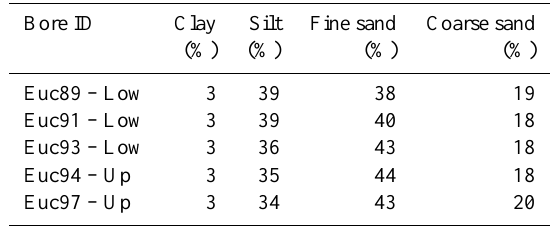
Table 2. Median grain size compositions for sampled profiles used to estimate a range of values for S y in Eq. (1). Bore